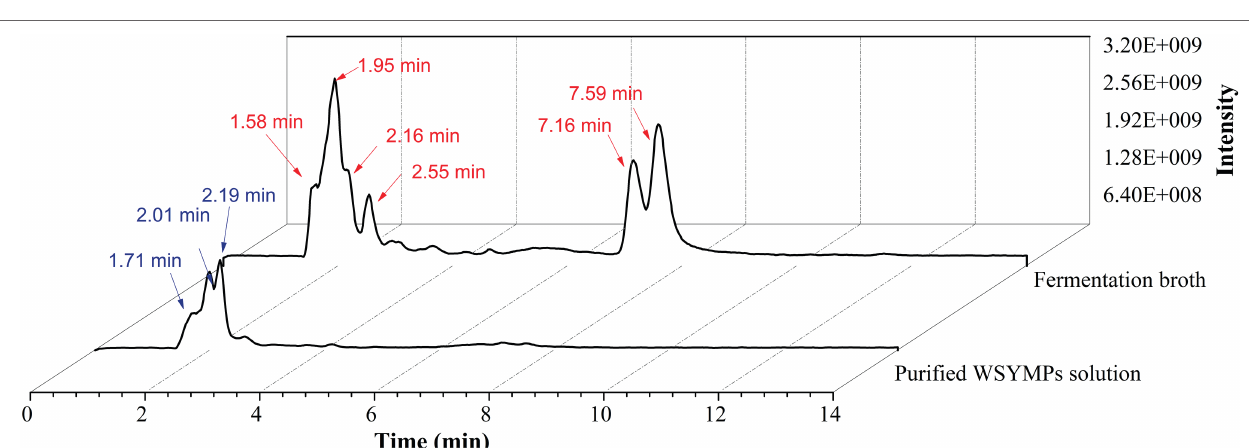
FIGURE 7 | Ultra-high-performance liquid chromatography analysis of fermentation broth and WSYMP